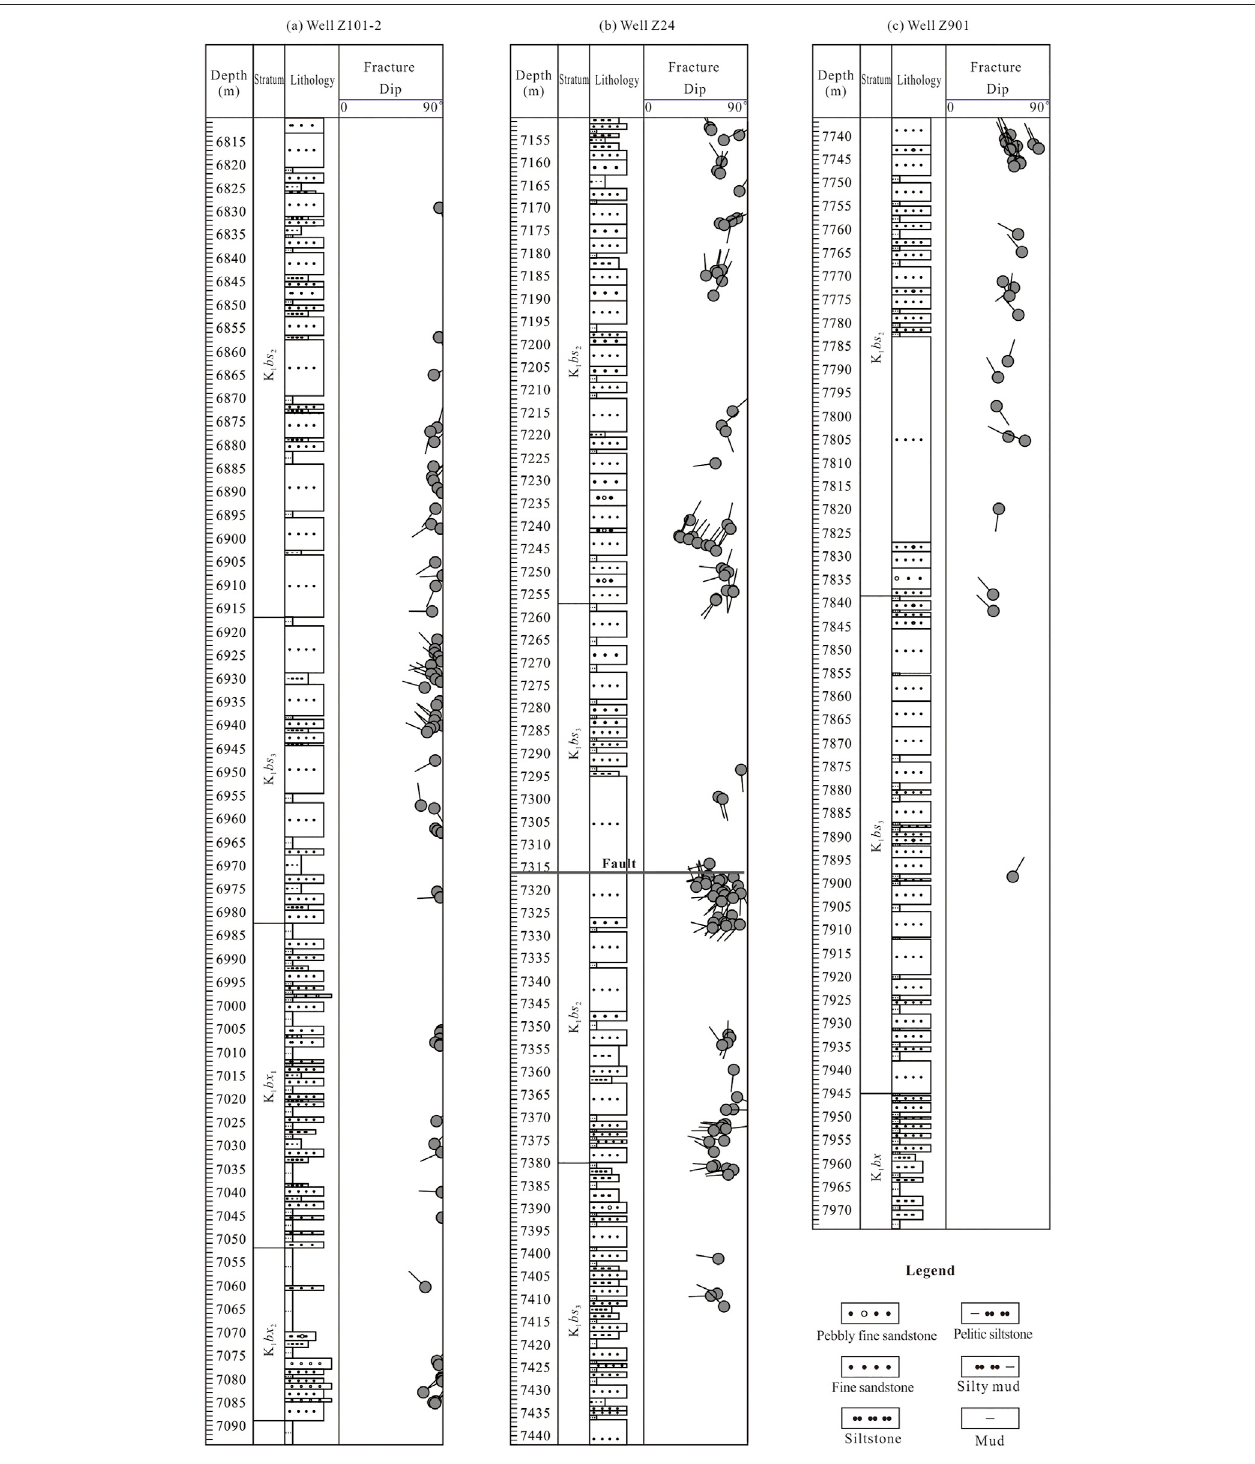
FIGURE 6 | (A) Fracture identi fi cation of imaging logs in Well Z24, with a total of 102 fractures identi fi ed; (B) fracture identi fi cation of imaging logs in Well Z101-2, with a total of 67 fractures identi fi ed; (C) fracture identi fi cation of imaging logs in Well Z901, with a total of 32 fractures identi fi ed.